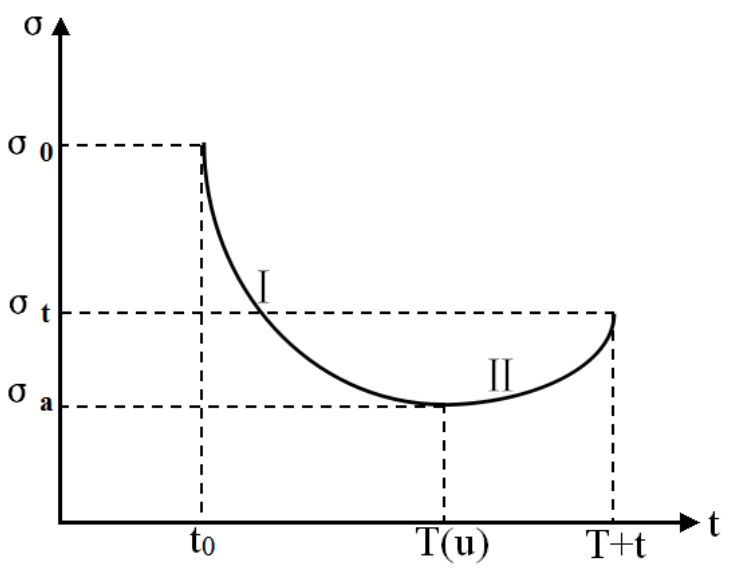
Figure 15. Time-varying characteristics of earth